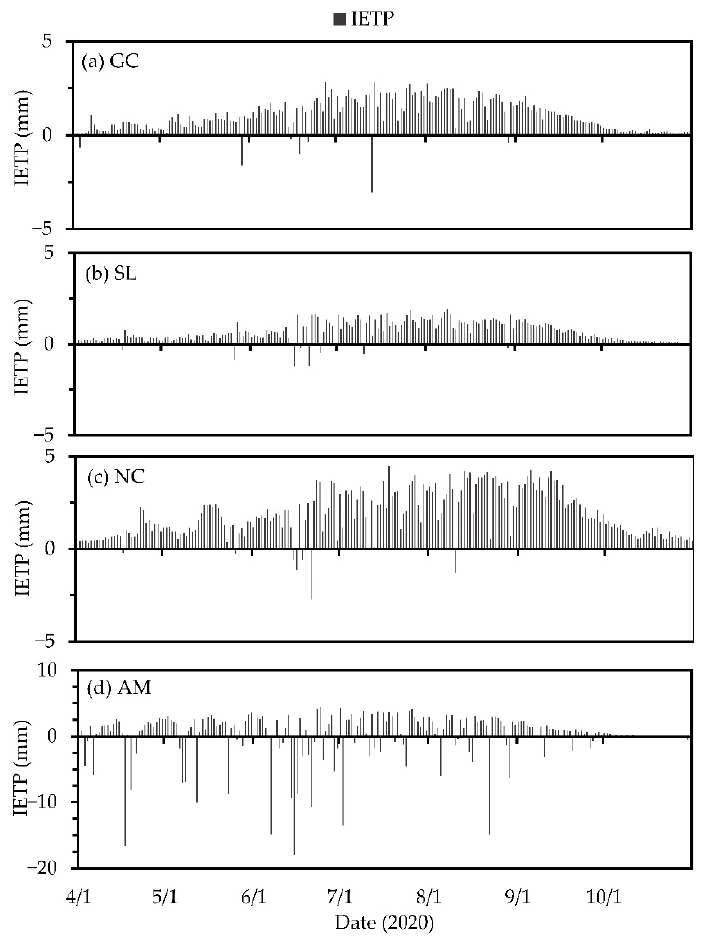
Figure 7. Change characteristics of IETP (the difference between ET and precipitation) at four ob- servation stations in the Qaidam Basin in 2020. observation stations in the Qaidam Basin in